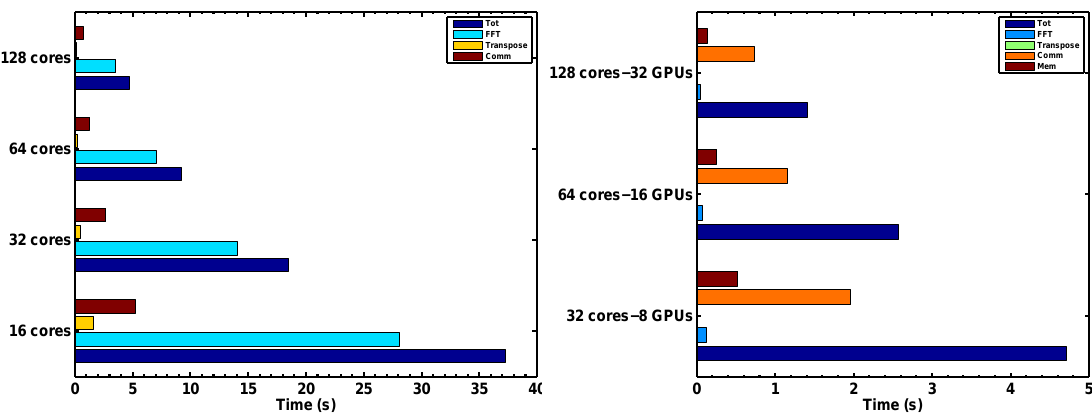
Figure 4. Process timers (total time and operation times) for ( left ) CPU-only ( right ) GPU runs on an anisotropic grid using configuration 3 in Table 3. Note the nearly ideal scaling of each of the timers with